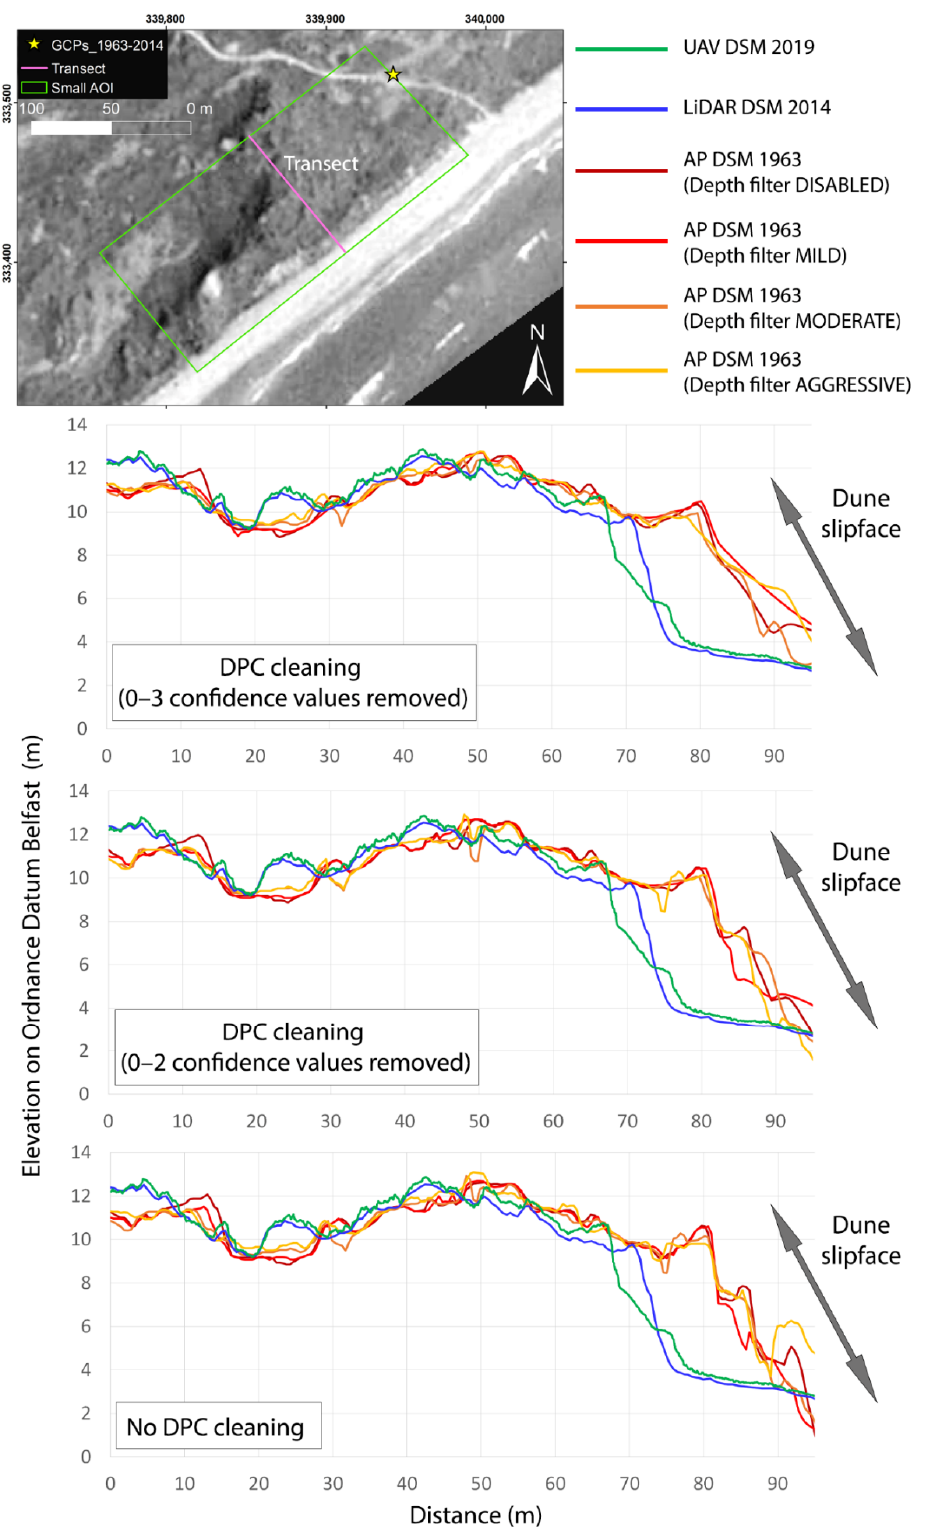
Figure 8. Reference transect showing the differences between structure-from-motion methods used to build the 1963 digital surface model and the DSMs derived from light detection and ranging (LiDAR) and unmanned aerial vehicle (UAV) datasets. In the top right, the transect location is shown on the 1963 orthophoto derived from the SfM process. The graticule in TM75/Irish Grid (transverse mercator) projection.